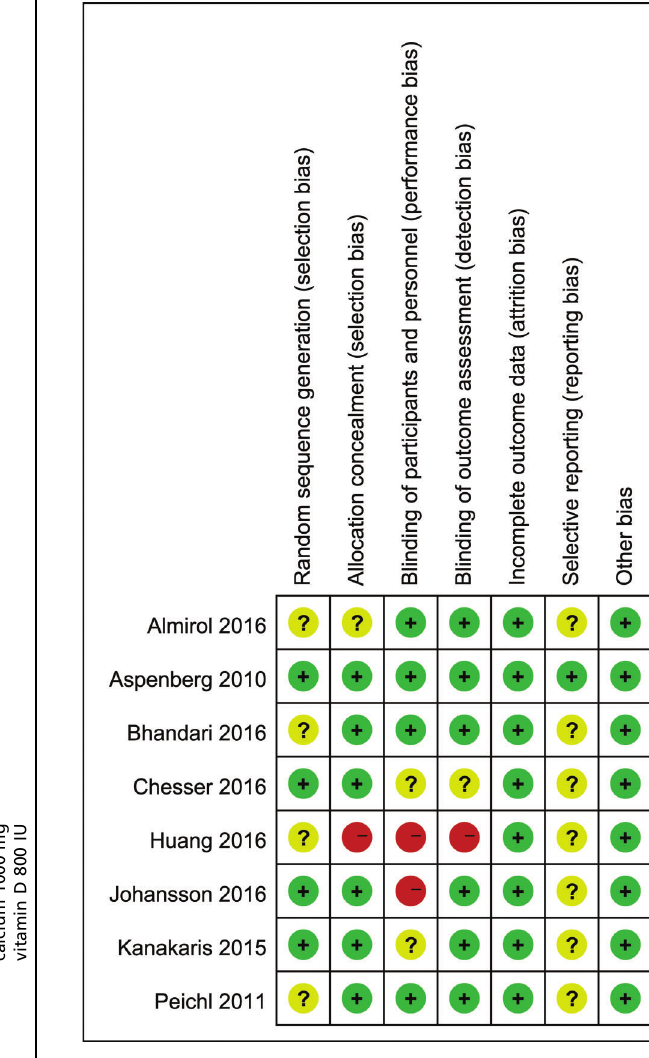
Fracture pain degree